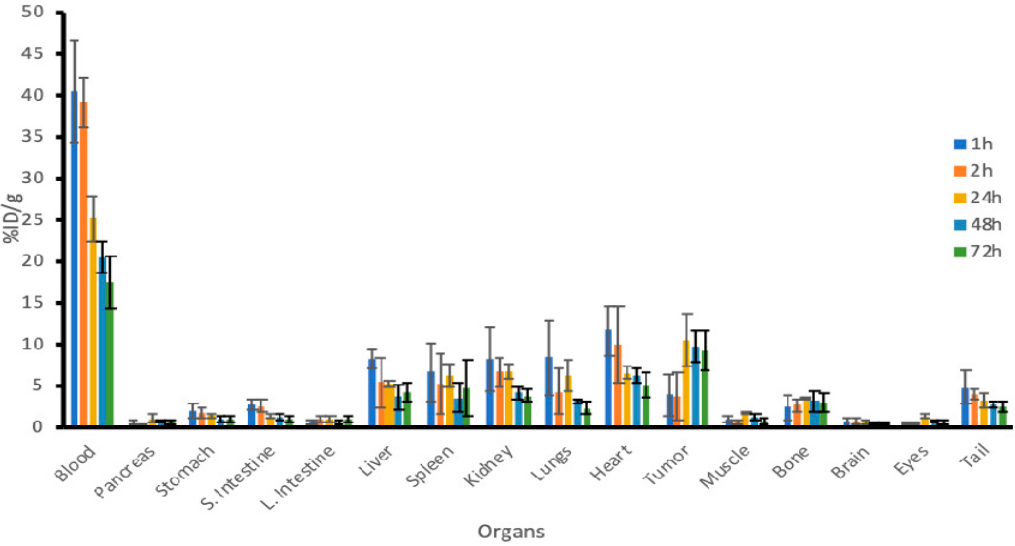
Figure 2. Detailed biodistribution of 111 In-h8C3 in B16-F10 tumor-bearing mice.